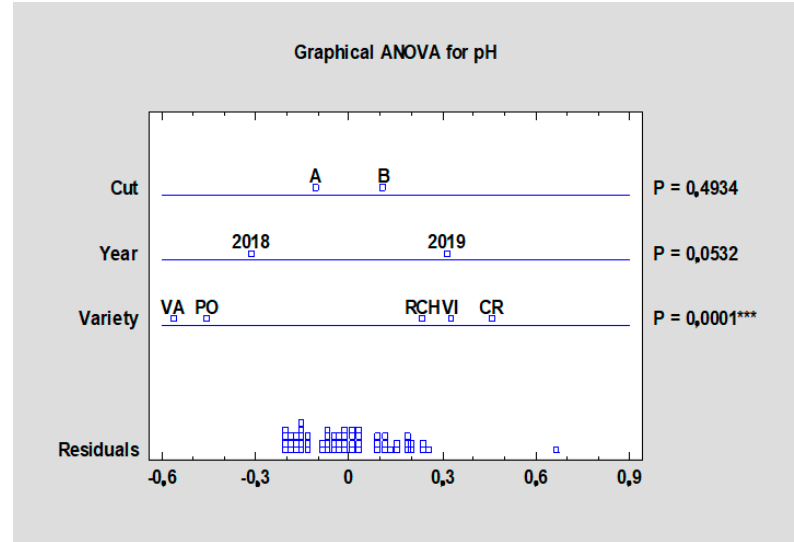
Figure 12. Effect of the experimental year, cultivar, and term of the harvest on the pH in the rhubarb cultivars. Abbreviations: PON, ´Poncho´; CRE, ´Canadian Red´; VAL, ´Valentine´; RCH, ´Red Champagne´; VIC, ´Victoria´. LSD test with significance: p ≤ 0.001 (***).